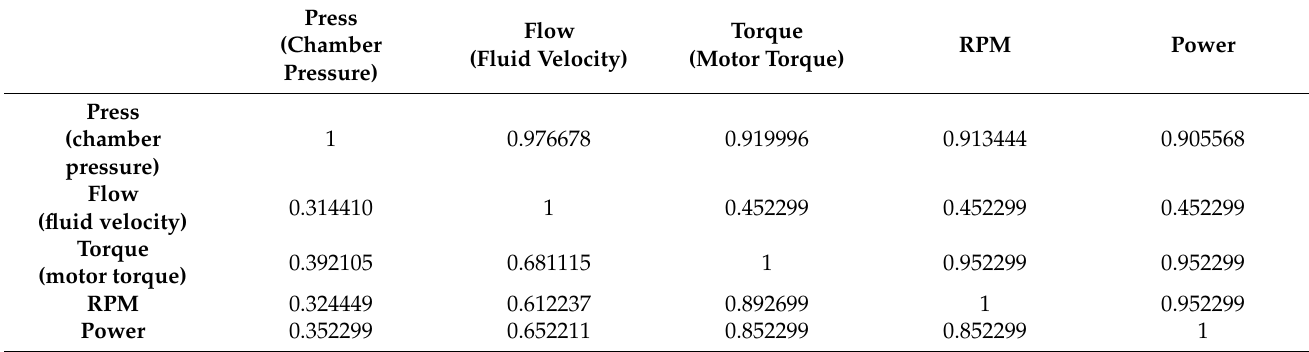
Table 5. Result of correlation